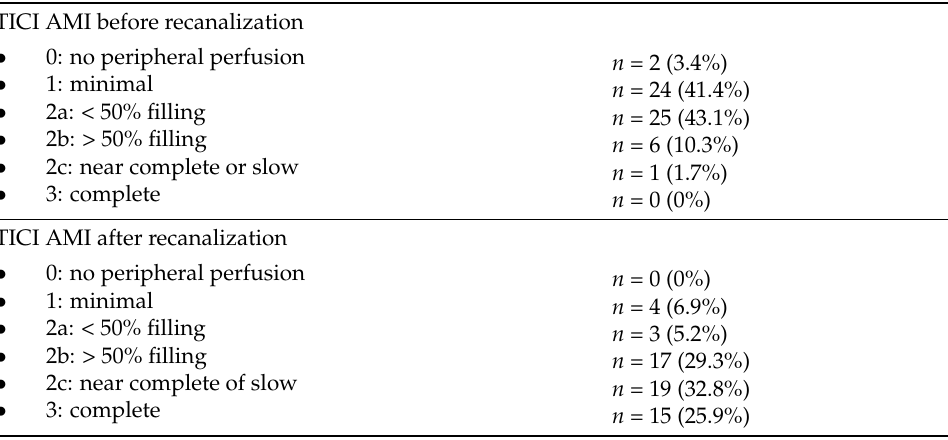
Table 3. Change in TICI AMI before and after recanalization. TICI AMI before